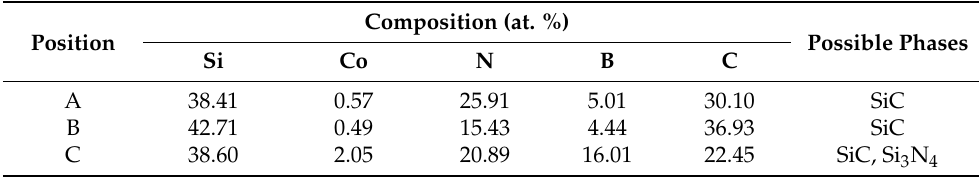
Table 2. The EDS results of the points signed in Figure 7b,c. Position